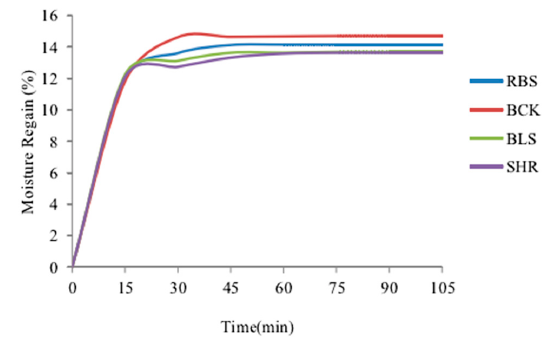
Figure 8. Moisture regain of the scoured wool.